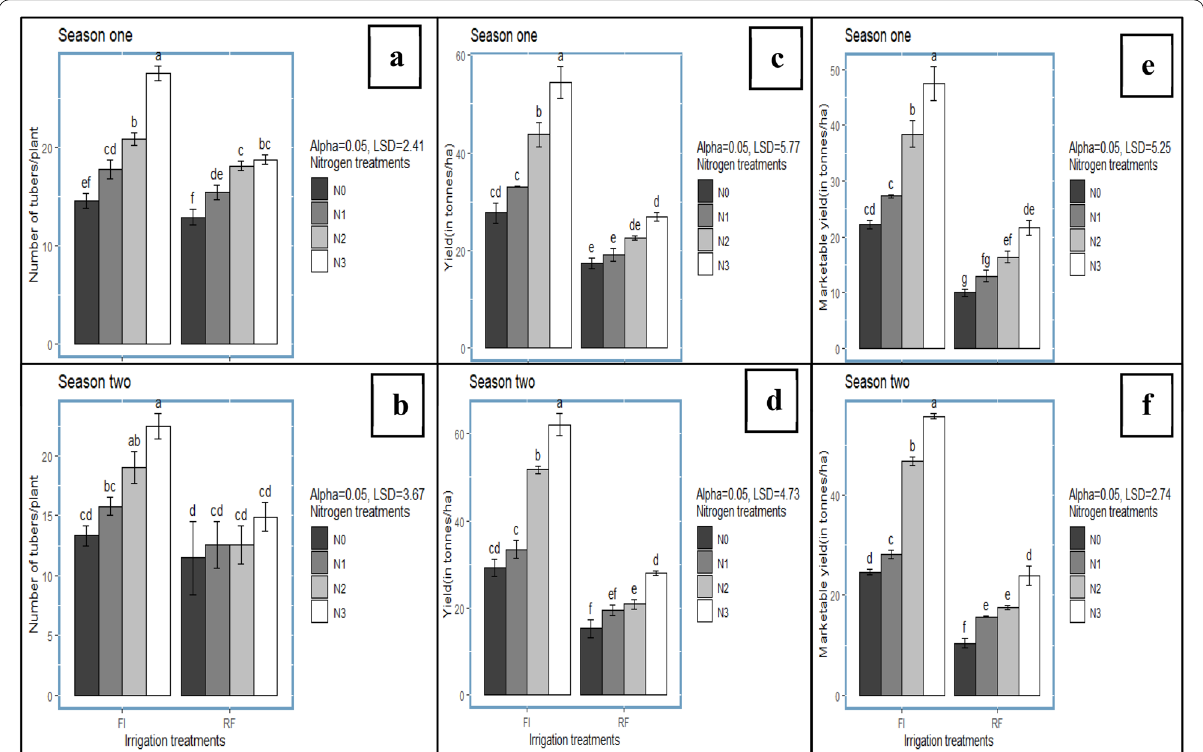
Fig. 3 Means separation of tuber number per plant, total tuber yield and marketable tuber yield of different growing seasons. Different letters indicate significant